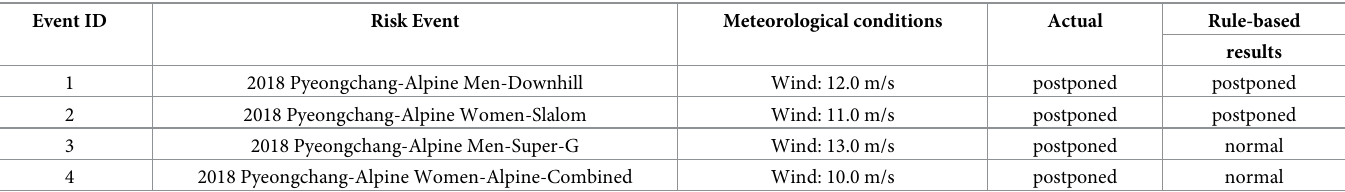
Table 8. Results of meteorological risk assessment for 4 alpine skiing